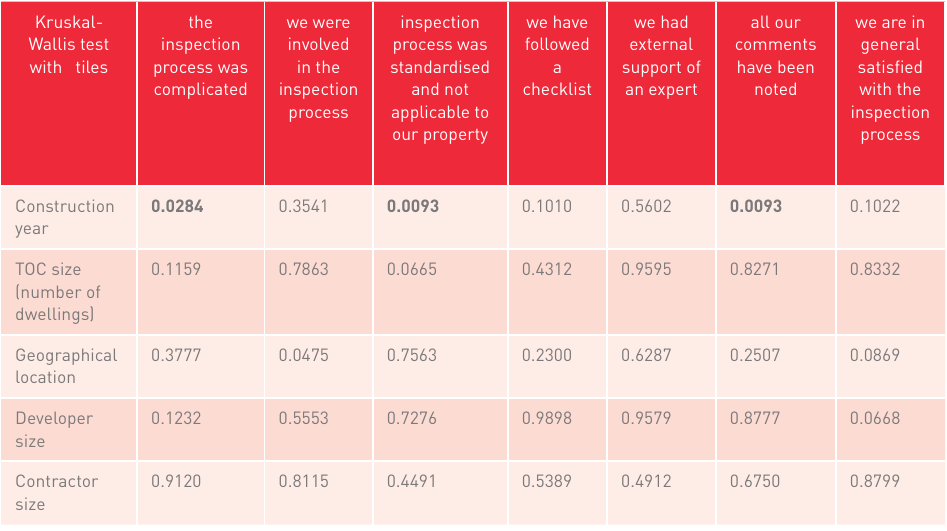
Perception of the inspection process, p-values Kruskal-Wallis test with